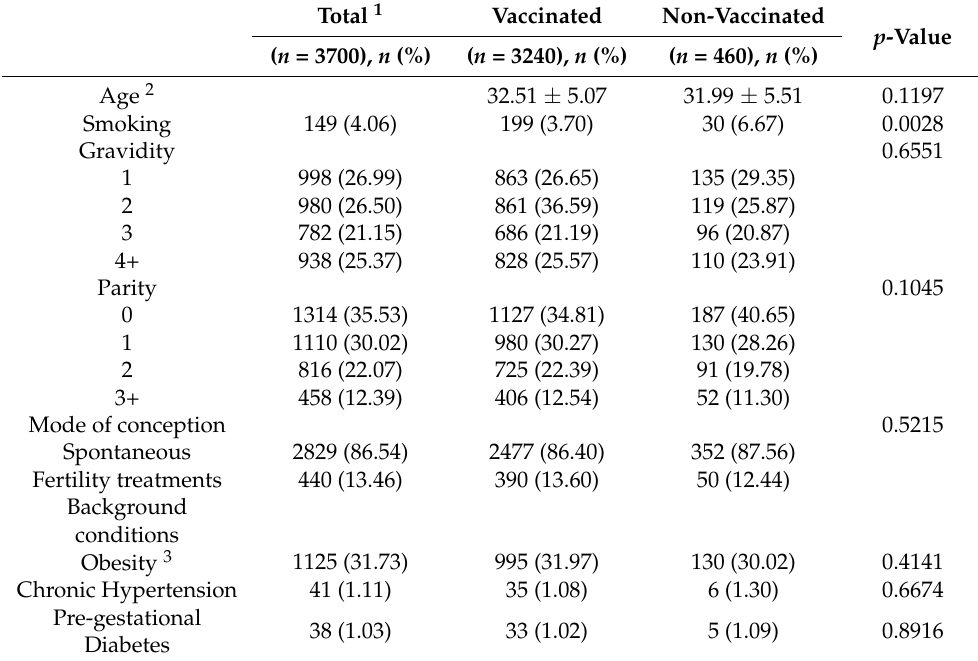
Table 1. Maternal characteristics.